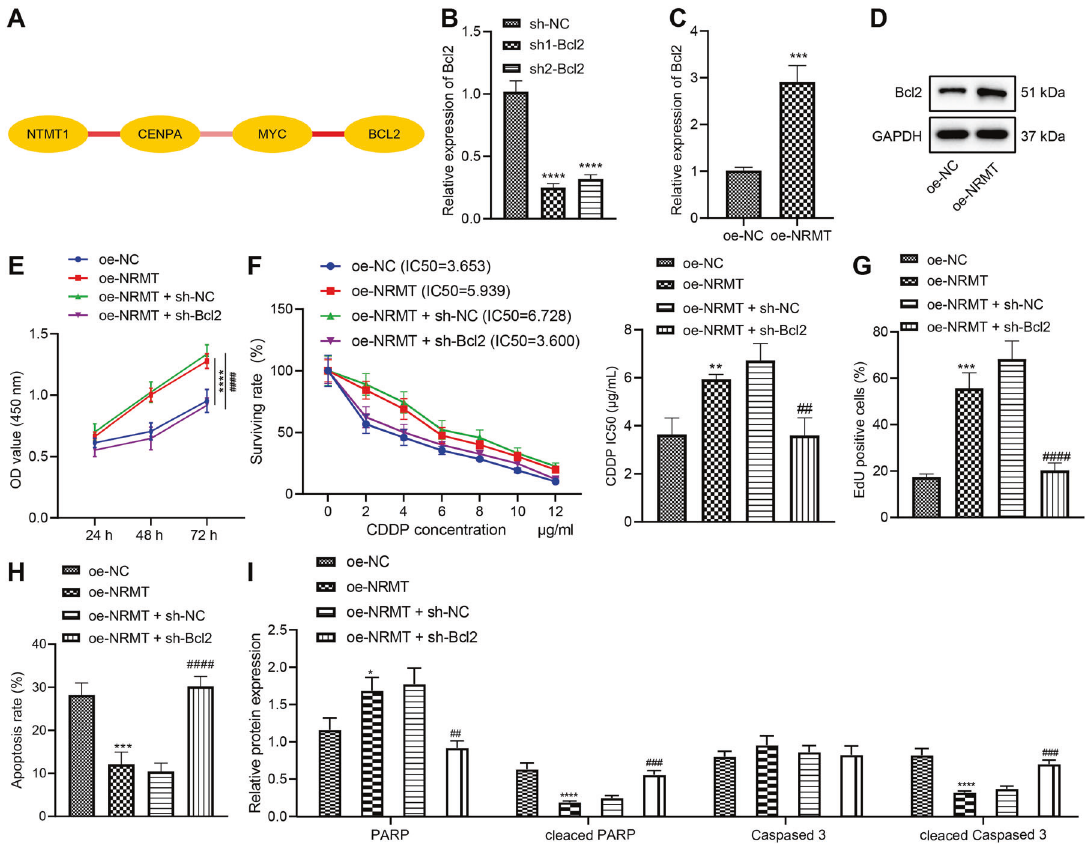
Fig. 5 NRMT inhibits chemosensitivity of WERI-RB-1/CDDP cells through Bcl2. A The interaction among NRMT, CENPA, Myc, and Bcl2 predicted by String. The redder the line between genes, the stronger the interaction, and the whiter the weaker. B The silencing ef fi ciency of Bcl2 determined by RT-qPCR (* p < 0.05 vs. cells transfected with sh-NC). C The expression of Bcl2 determined by RT-qPCR. D The expression of Bcl2 determined by western blot analysis (* p < 0.05 vs. cells transfected with oe-NC). E Cell viability assessed by CCK8 assay. F IC 50 value determined by CCK8 assay. G Cell proliferation assessed by EdU assay. H Cell apoptosis assessed by fl ow cytometry. I Expression of PARP, Cleaved PARP, caspase 3, and Cleaved caspase 3 in cells after transfection determined by western blot analysis. * p < 0.05 vs . cells transfected with oe-NC; # p < 0.05 vs. cells co-transfected with oe-NRMT + sh-NC. * /# p < 0.05; ** /## p < 0.01; *** /### p < 0.001; **** /#### p < 0.0001. The experiment was independently repeated three